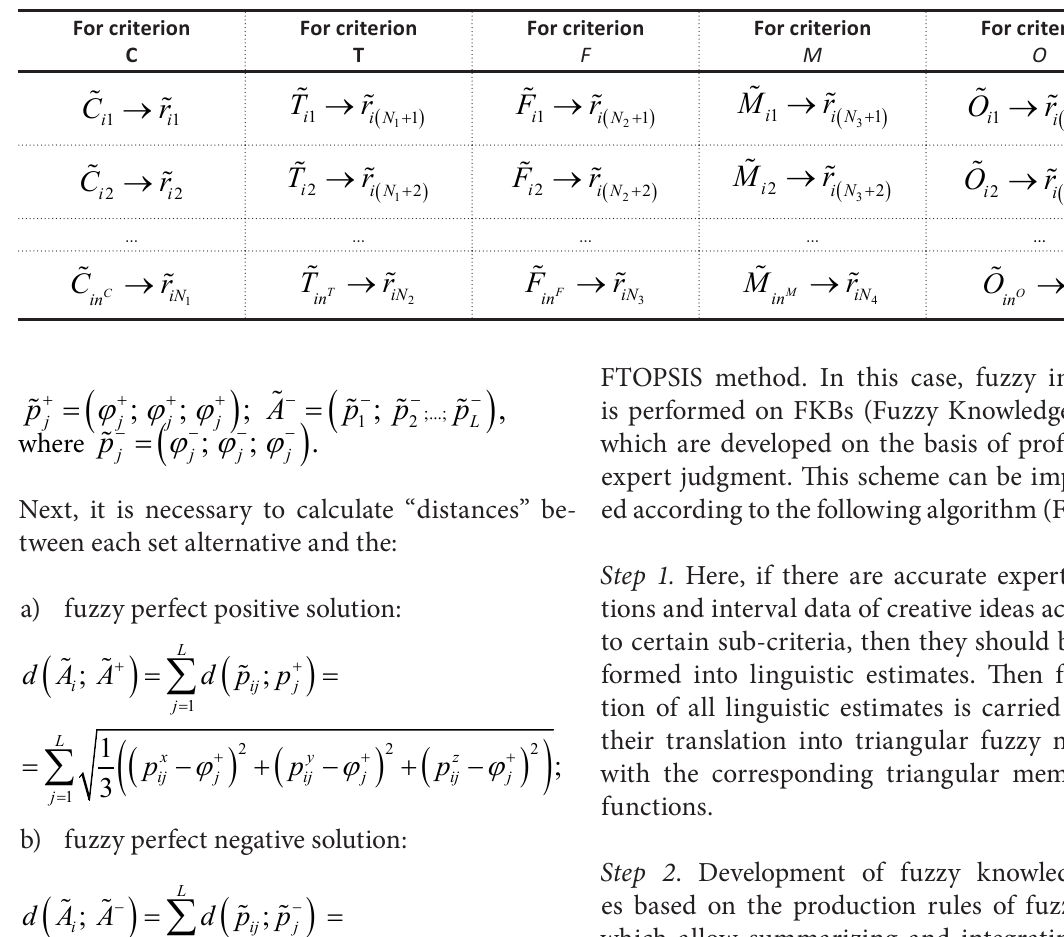
Table 3. Fuzzy matrix of “solutions” for the application of fuzzy TOPSIS